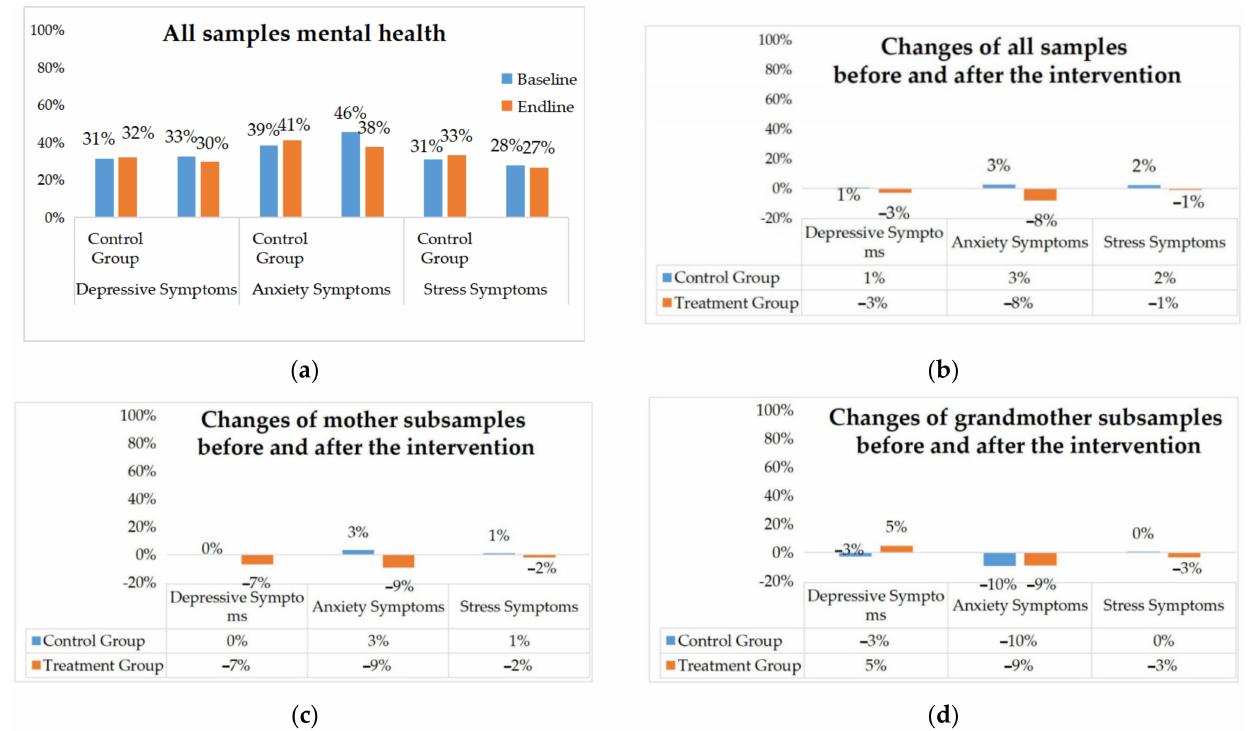
Figure 4. Female caregivers’ mental health before and after the intervention: ( a ) All samples’ mental health; ( b ) changes in all samples before and after the intervention; ( c ) changes in mother subsamples before and after the intervention; ( d ) changes in grandmother subsamples before and after the